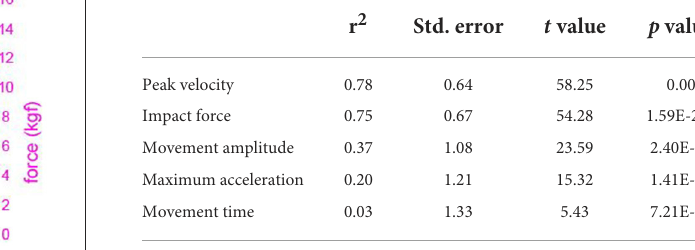
TABLE 1 Results of simple regression analysis of each dependent variable for ball travel